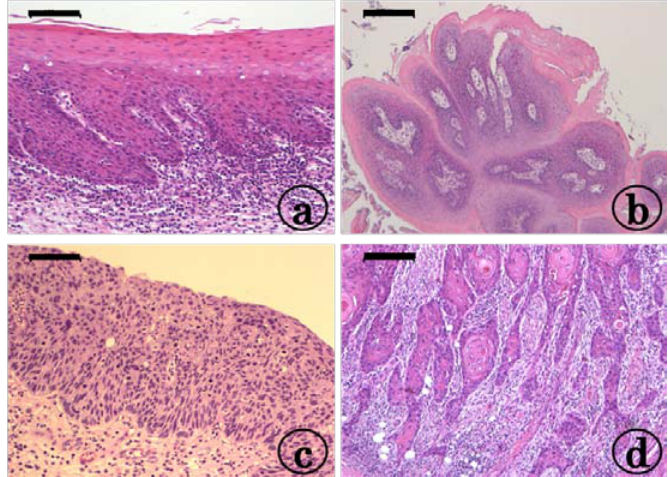
Figure 1. Representative photos of tongue lesions in the female KAD rats that received 20 ppm 4-NQO in drinking water for eight weeks. ( a ) Tongue dysplasia with moderate atypia; ( b ) squamous cell papilloma; ( c ) squamous cell carcinoma in situ; and ( d ) invasive squamous cell carcinoma (well differentiated). H&E staining, bars: ( a ) 100 µ m, ( b ) 200 µ m, ( c ) 100 µ m and ( d ) 100 µ m.